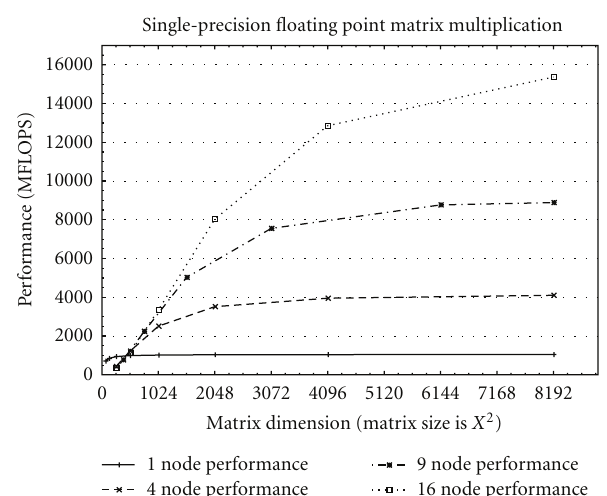
Figure 14: Single ML410 base system configuration for MAcc Array with AIREN.